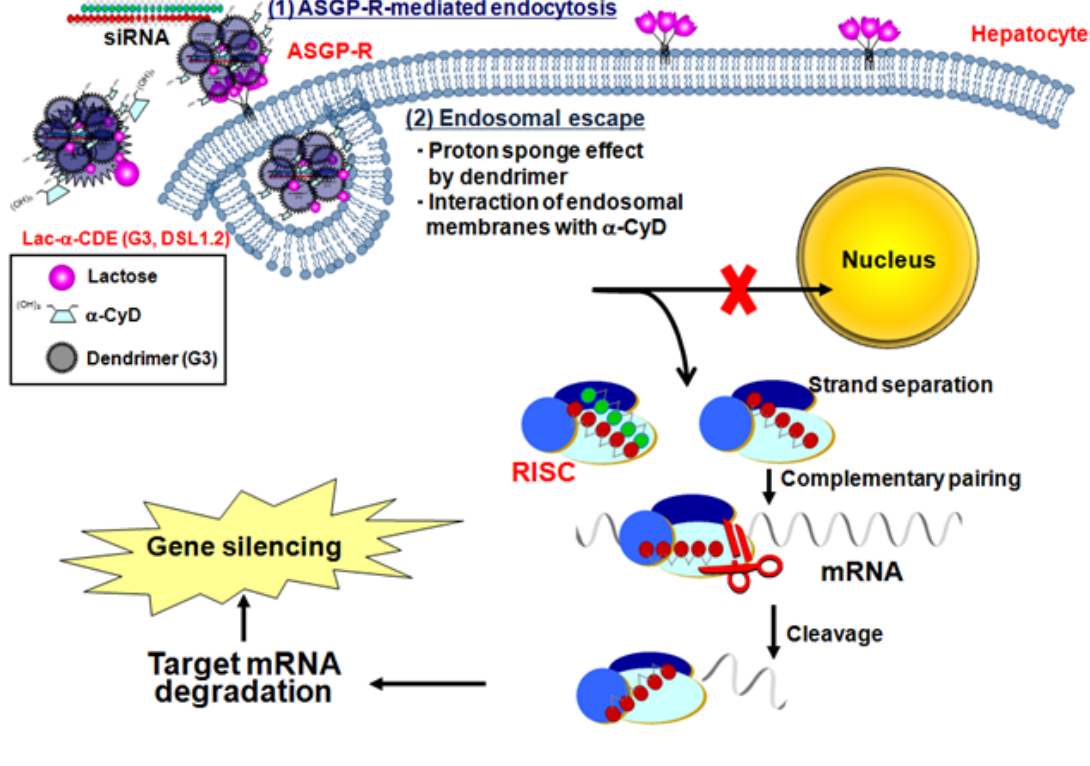
Figure 3. Proposed mechanisms for hepatocyte-selective RNAi effects by Lac- α -CDE (G3, DSL